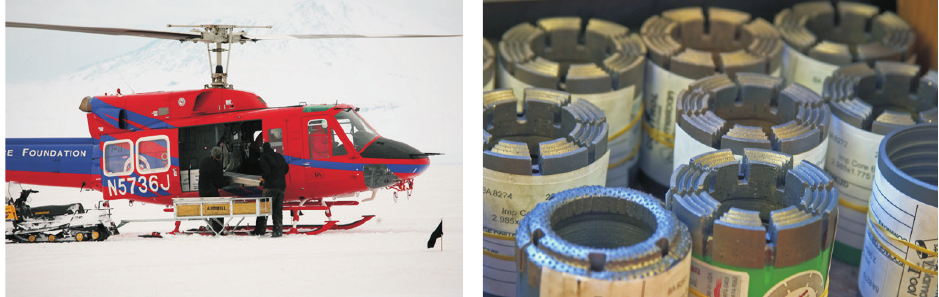
Figure 4. Diamond-impregnated drilling bits enable the ANDRILL drilling system to recover high-quality core, with up to 98% core recovery through glacial and glacimarine